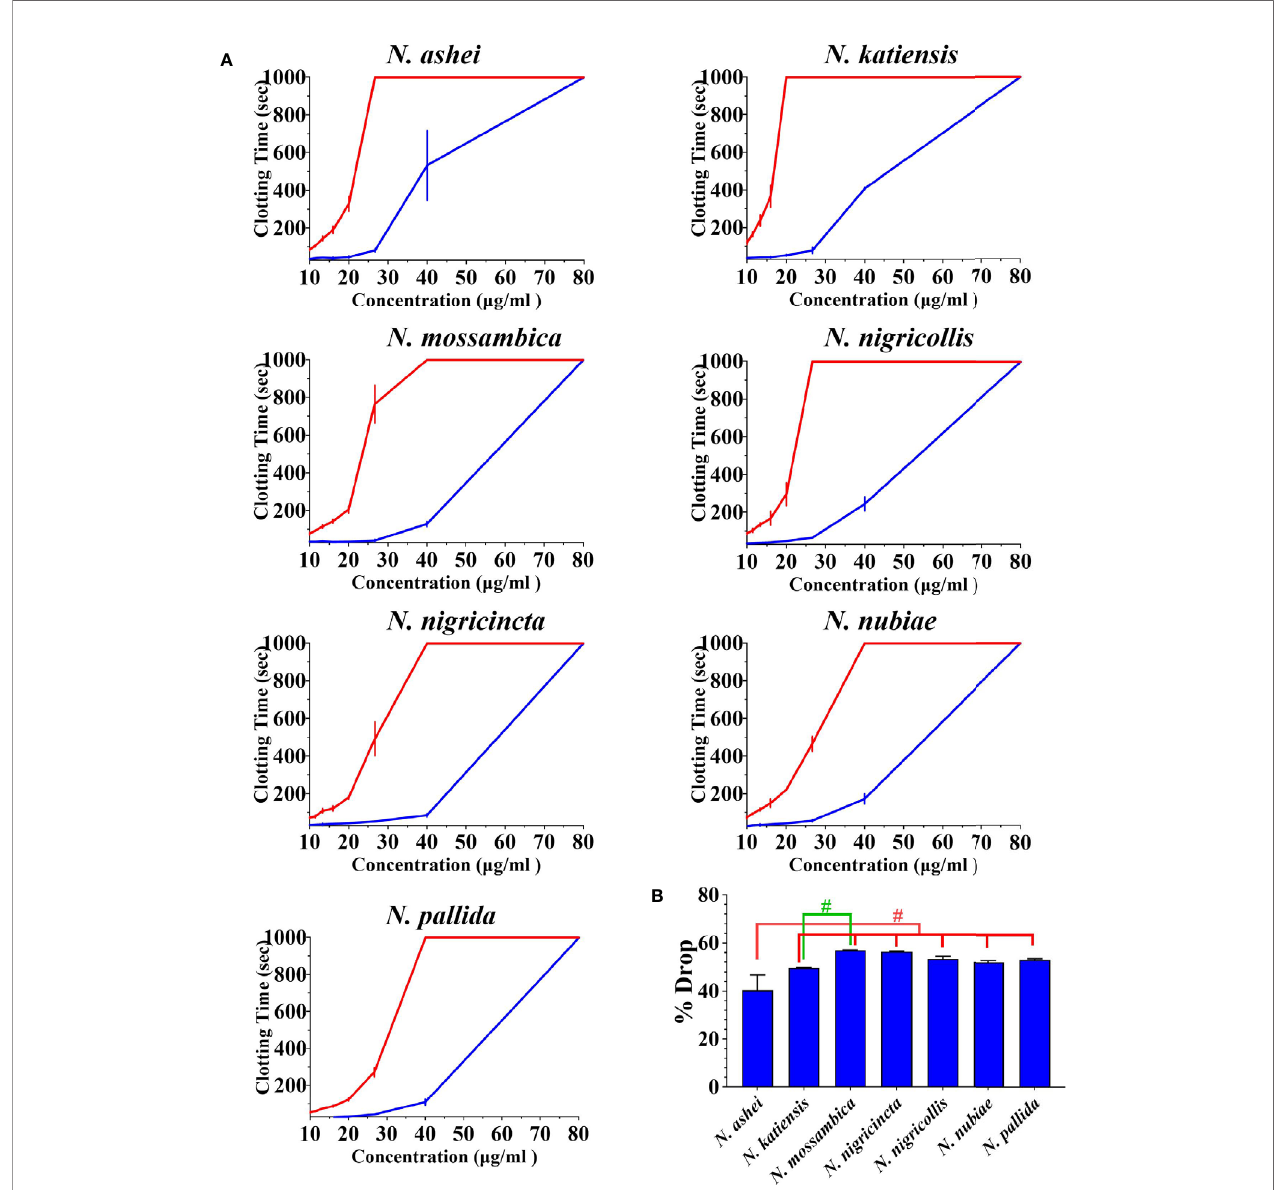
FIGURE 2 | (A) 8-point concentration curves of venom vs varespladib. X-axis showing concentrations of venom in m g/ml and y-axis showing clotting times in seconds of human plasma with venom and relative inhibition ef fi cacy of varespladib. Venom-induced clotting times shown as red curves, effect of venoms after pre- incubation with varespladib-Na as blue curves. Values are mean ± SD of N = 3 and shown as dots with error bars. Some error bars are too small to see. (B) Bar graphs of percentage drop of plasma clotting time due to induction varespladib-Na as blue bars. All Values are mean ± SD of N = 3. # Represents statistical signi fi cance in percentage drops ( p < 0.05) in Tukey ’ s multiple comparisons test at 95.00% con fi dence